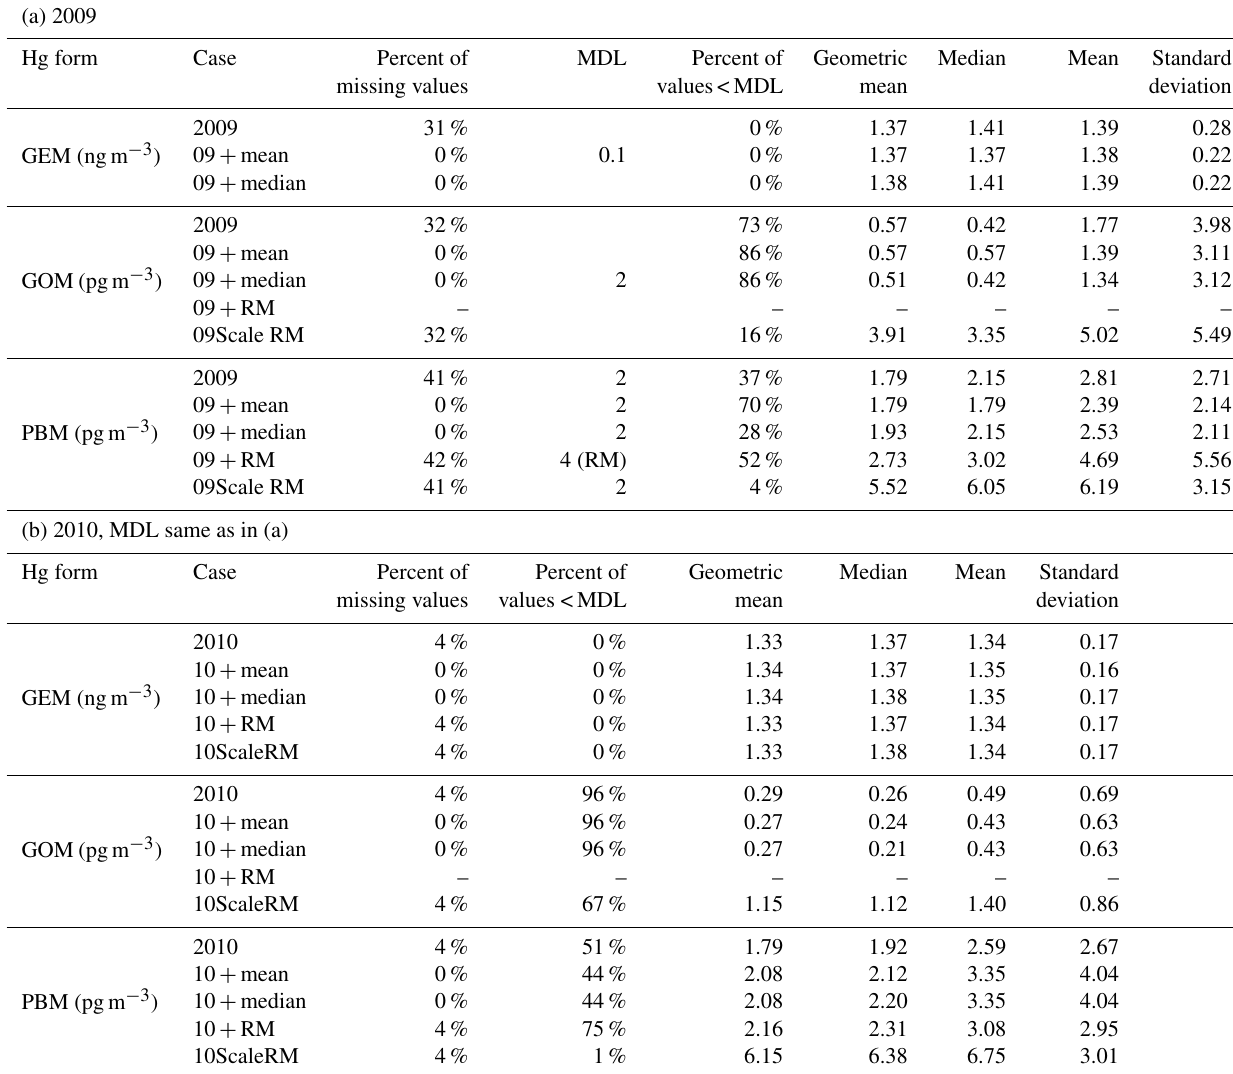
Table 9. General statistics of speciated Hg with different data treatment